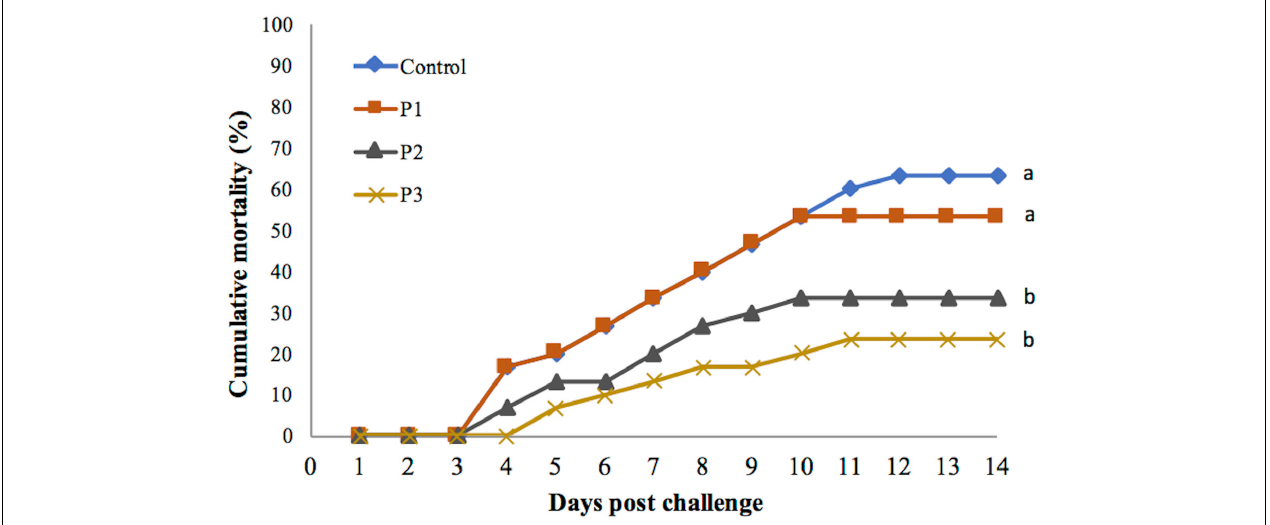
FIGURE 1 | Cumulative mortality percentage of juvenile whiteleg shrimp fed with different doses of P. pentosaceus for 60 days and experimentally challenged with V. parahaemolyticus for 14 days. Data with different letters are significantly different among groups ( p < 0.05).